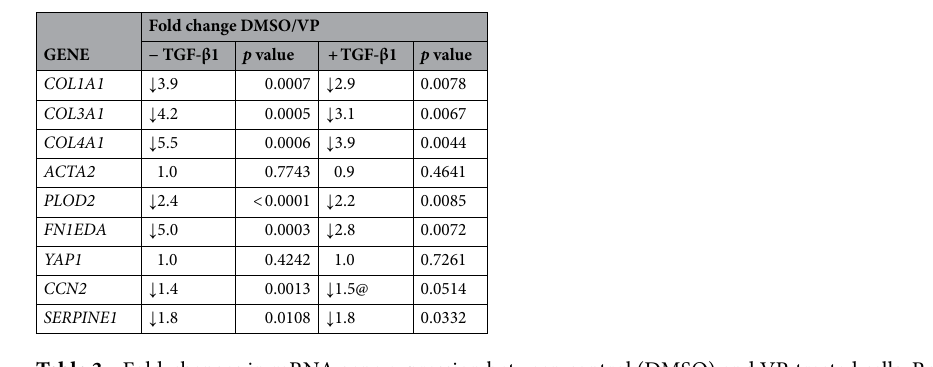
Table 3. Fold-changes in mRNA gene expression between control (DMSO) and VP-treated cells. Ratio of gene expression decrease after 48 h treatment with DMSO vs VP. ↓ : Indicates decrease. @ Indicates that the decrease is statistically non-significant, although a trend is